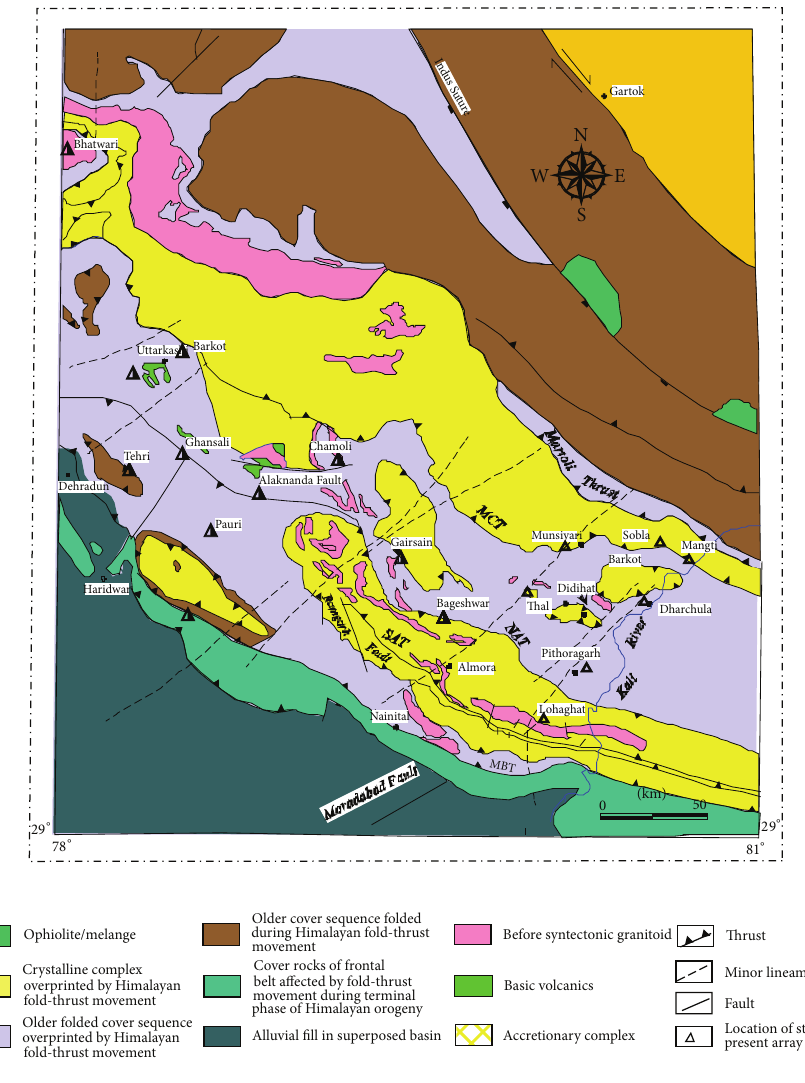
Figure 3: Location of strong motion recorders in the Kumaon and Garhwal Himalaya. The geology and tectonics of the region are after Geological Survey of India [22]. Empty triangles denote the stations maintained by the National Geophysical Research Institute and Department of Earth Sciences, Indian Institute Technology, Roorkee, and half-filled triangles denote stations maintained by the Department of Earthquake Engineering, Indian Institute Technology,